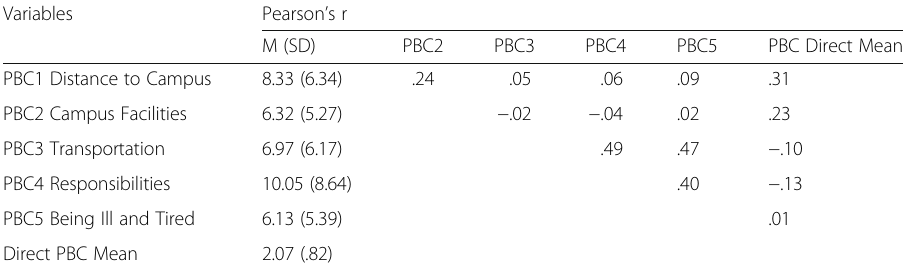
Table 1 Descriptive Statistics and Correlations of PBC Measures for the FLL Group ( n = 684) Variables Pearson ’ s r